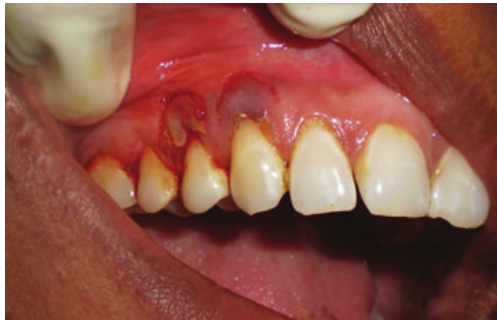
Figure 2: Semilunar incision placed apically.